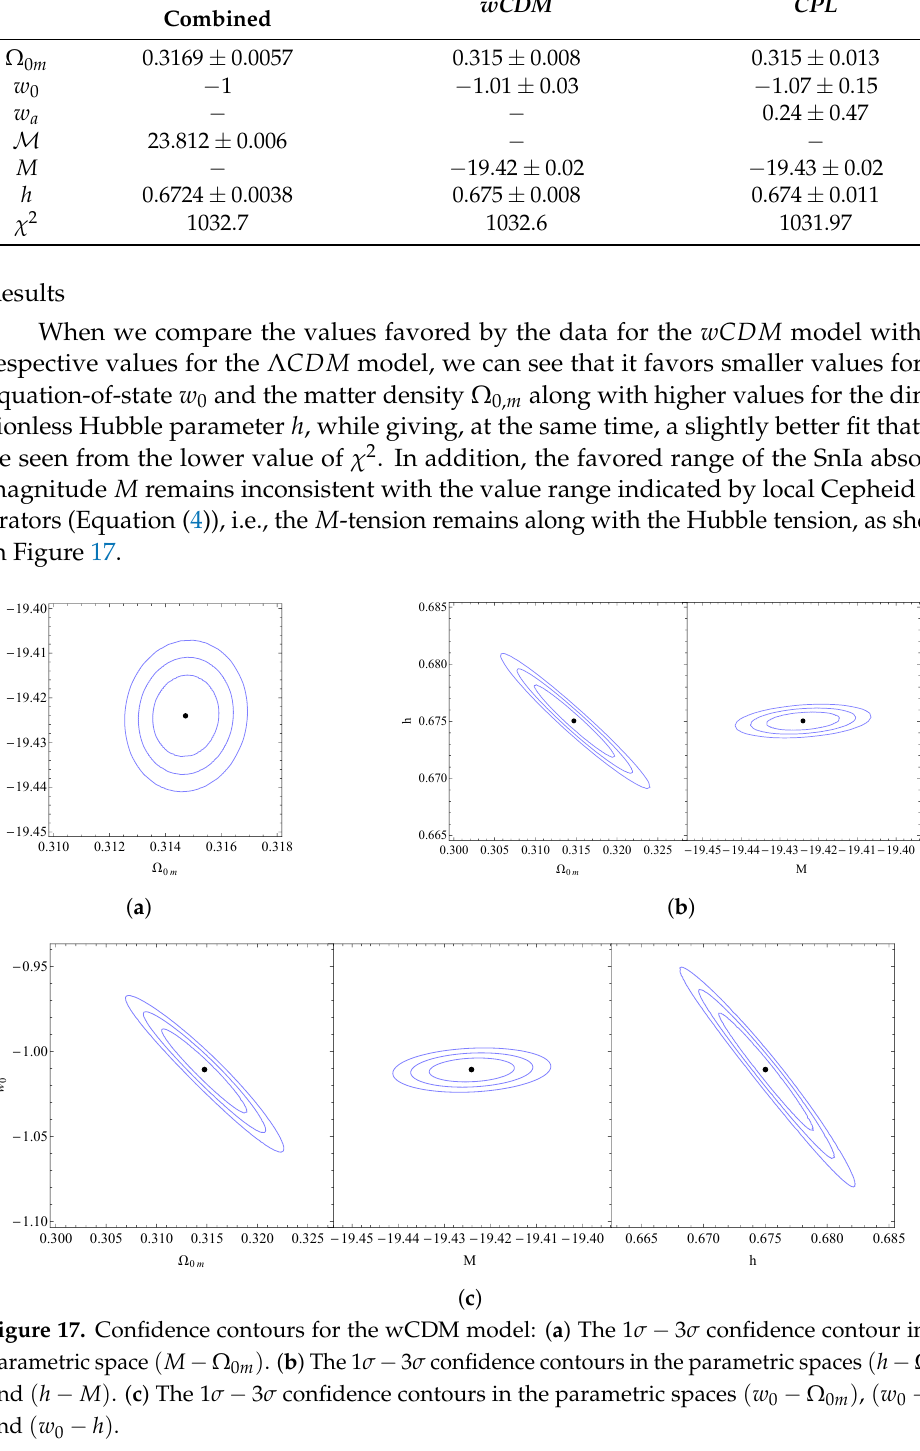
Table 3. Table containing the best-fit values for the Λ CDM , wCDM and CPL models using both the CMB and BAO measurements and data from Type Ia supernovae. Λ CDM wCDM